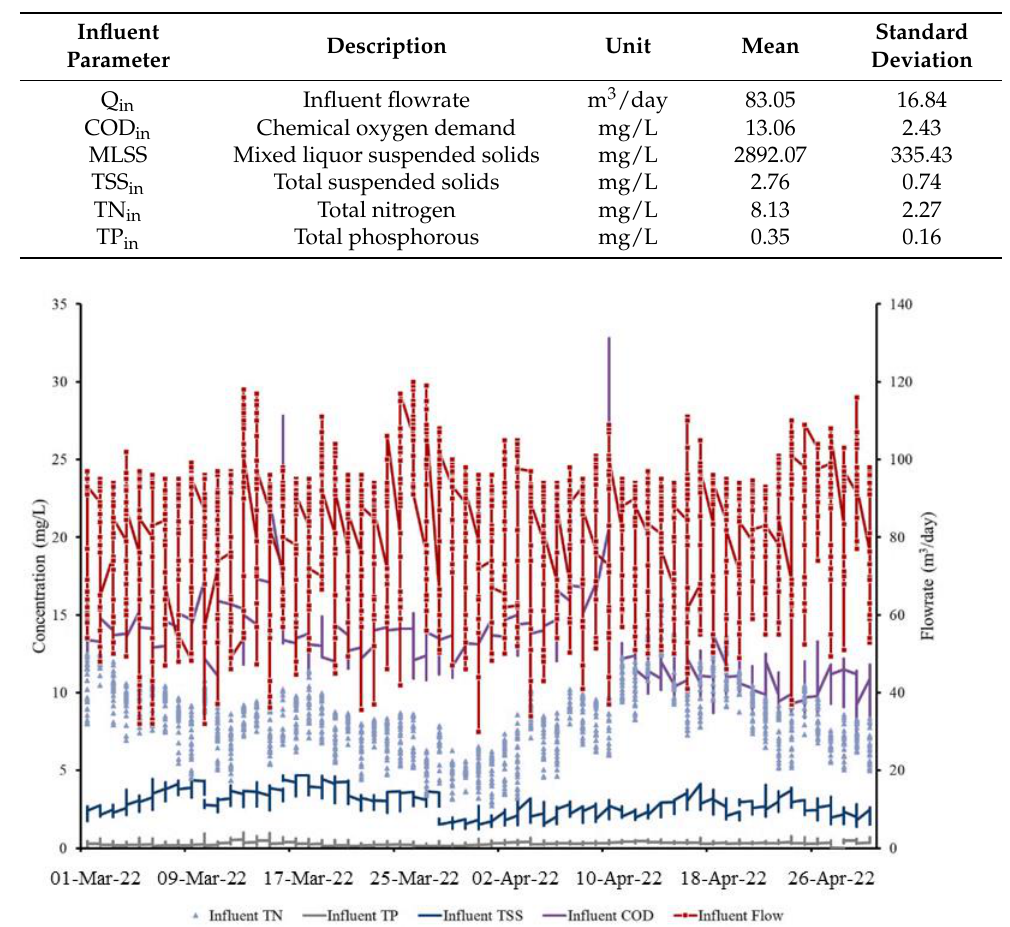
Table 1. Process variables in an H-municipal full-scale treatment plant.